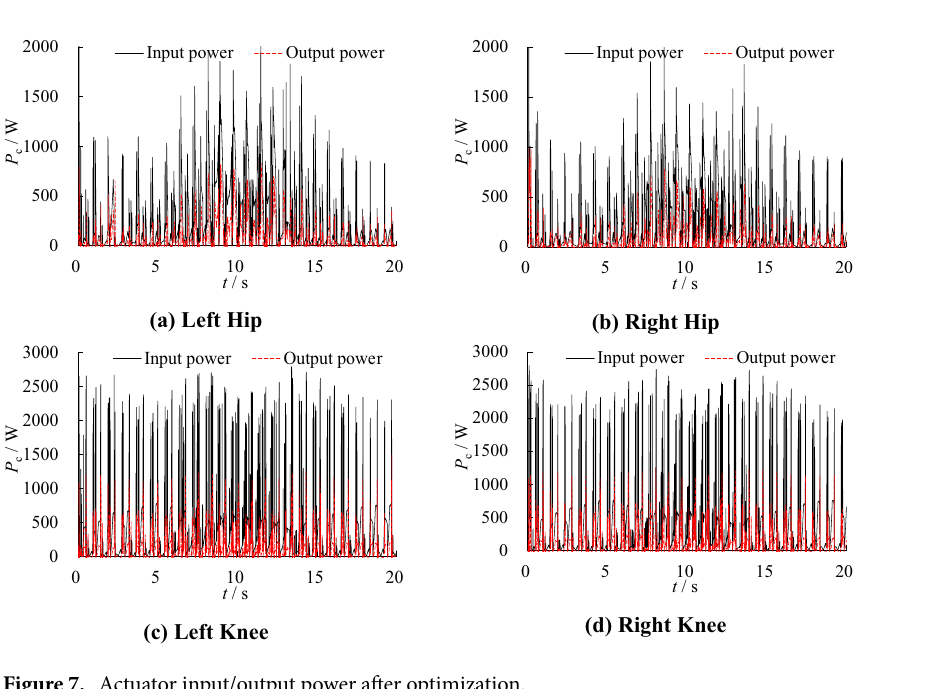
Figure 7. Actuator input/output power after